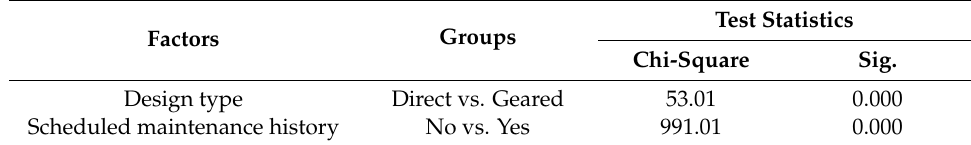
Figure 3. Nelson–Aalen cumulative hazard functions of wind turbines based on the operational, climatic and geographical factors. ( a ) Design type ( b ) Climatic regions ( c ) Turbine age ( d ) Scheduled Table 5. Log-rank test results for comparison of the effect of factors impacting on wind turbine system failures.